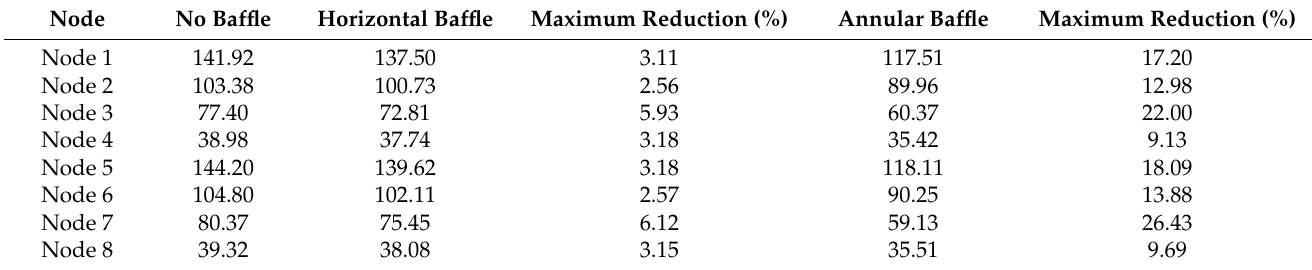
Table 7. Base shear (KN) maximum percentage reduction in a flexible elevated storage